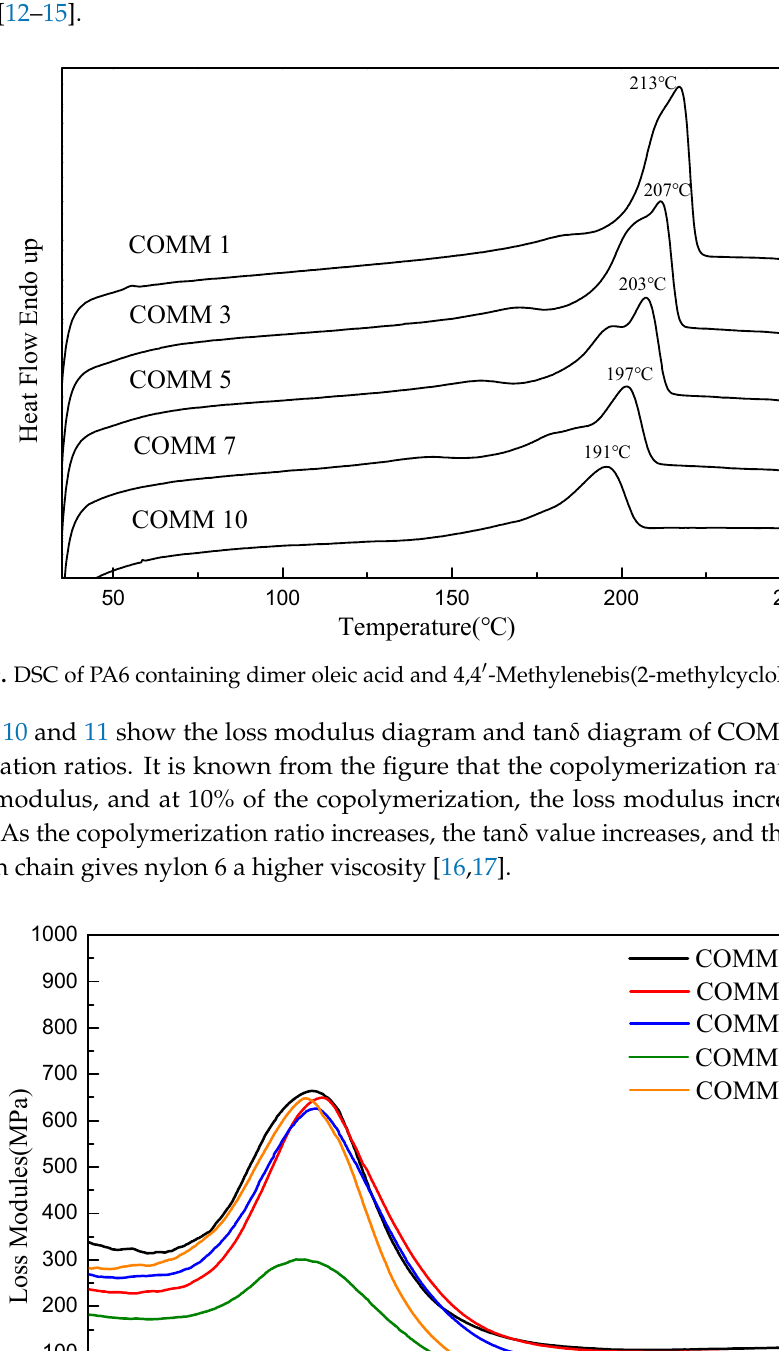
Figure 11. tan δ value for PA6 containing dimer oleic acid and 4,4'-Methylenebis(2- methylcyclohexylamine. 3.3.2. Crystallinity Figure 12 shows the XRD spectrum for different copolymerization ratios of COMM. It is seen that 1%, 3%, 5%, 7%, 10% of COMM increases with the proportion of MMCA. Crystallization at 19.5° and 24.0° results in an α -type doublet. The α 2 peak gradually disappears as the proportion of copolymerization increases. As the copolymerization ratio increases, the crystal structure is affected. [18,19,20,21].